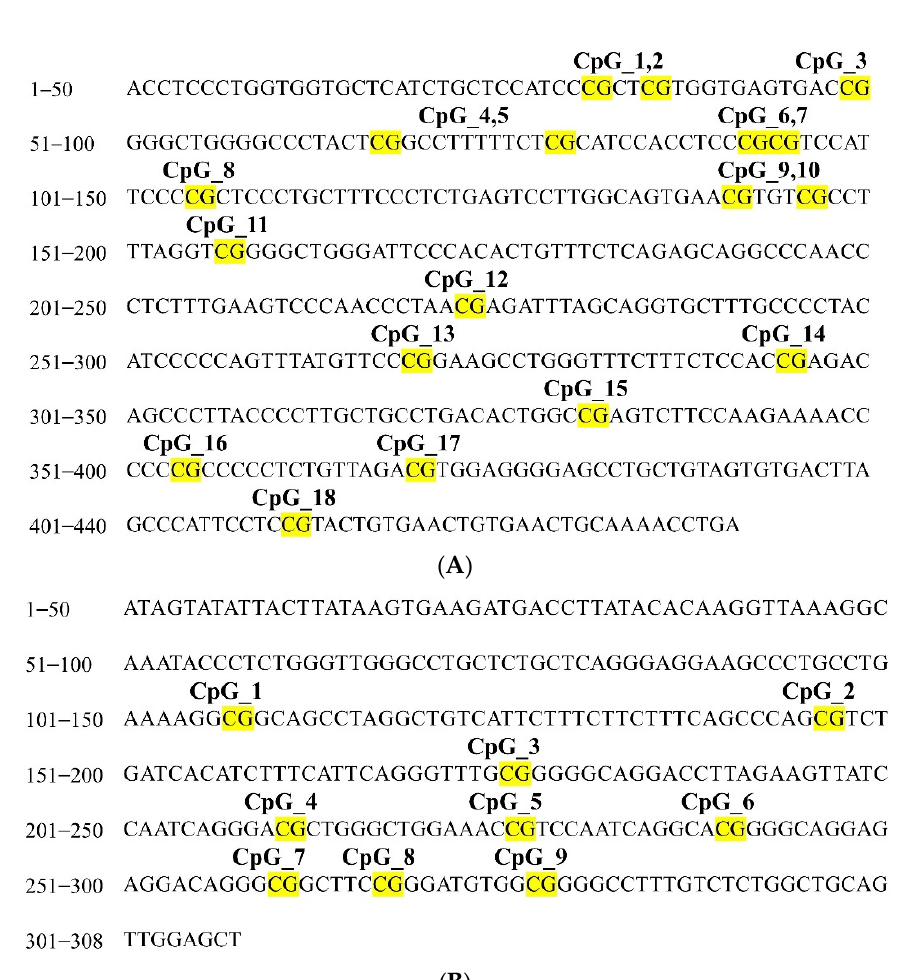
Figure 1. Schematic depiction showed the location of informative CpG sites in the ( A ) PTGER4 and ( B ) ZNF43 genomic loci. CG = CpG. To achieve a desired level of statistical power, the methylation level of the target genes were categorized into hypermethylation and hypomethylation groups, and the cut-off set for dichotomization was defined as the median value, as displayed in Table 3. Thereafter, the correlation of the PTGER4 and ZNF43 methylation levels at certain CpG sites with clinical outcomes was evaluated. With regard to ZNF43 methylation, CpG_5 hypermethylation in normal tissue corresponded to a considerably shorter RFS and PFS than CpG_5 hypomethylation, as determined through a Cox multivariate analysis [aHR (95% CI) = 2.33 (1.07–5.08) for RFS and 2.42 (1.19–4.91) for PFS] (Table 4). Hypermethylation in approximately half of all the CpG sites of tumor tissue that underwent PTGER4 methylation exhibited an unfavorable 5-year RFS, PFS, and OS, as indicated by the results of the Cox regression analysis (Table 4) and the Kaplan–Meier survival analysis. Therefore, CpG_4.5, CpG_15, and CpG_17 were selected because the patients who underwent hypermethylation at these CpG sites corresponded to undesirable clinical outcomes, as indicated by the results of a Cox regression (Table 4) and separation of the Kaplan–Meier survival curves. Further, the correlation between the hypermethylation of the diverse combinations of the aforementioned CpG sites and patient outcomes (Table 5) was assessed. All methylation levels at the CpG_4.5, CpG_15, and CpG_17 loci of PTGER4 methylation in neoplastic tissue above the site-specific optimum threshold values were correlated with significantly worse outcomes after adjustment for related confounding factors [aHR (95% CI) = 3.26 (1.38–7.73) for RFS, 2.35 (1.17–4.71) for PFS, and 4.32 (1.8–10.5) for OS]. The results of the Kaplan–Meier analysis of 5-year RFS, PFS, and OS